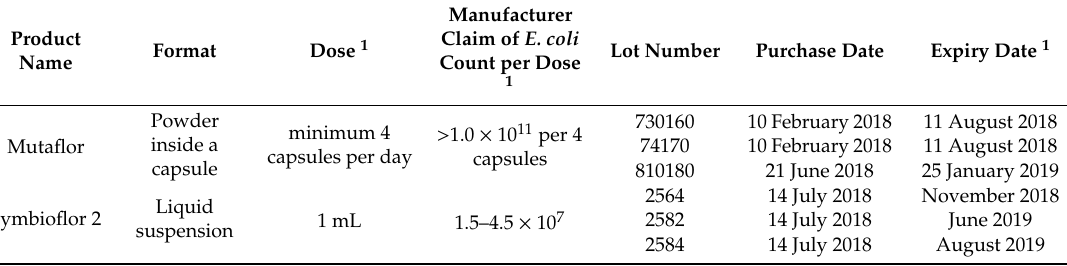
Table 1. Characteristics of studied E. coli probiotic products: Mutaflor and Symbioflor